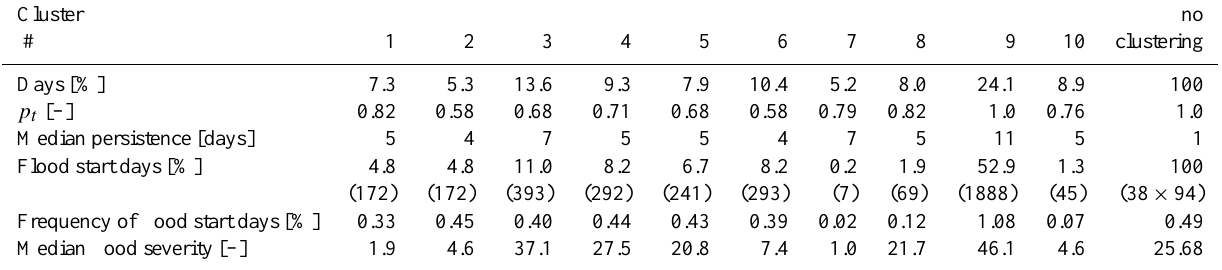
Table 2. Cluster